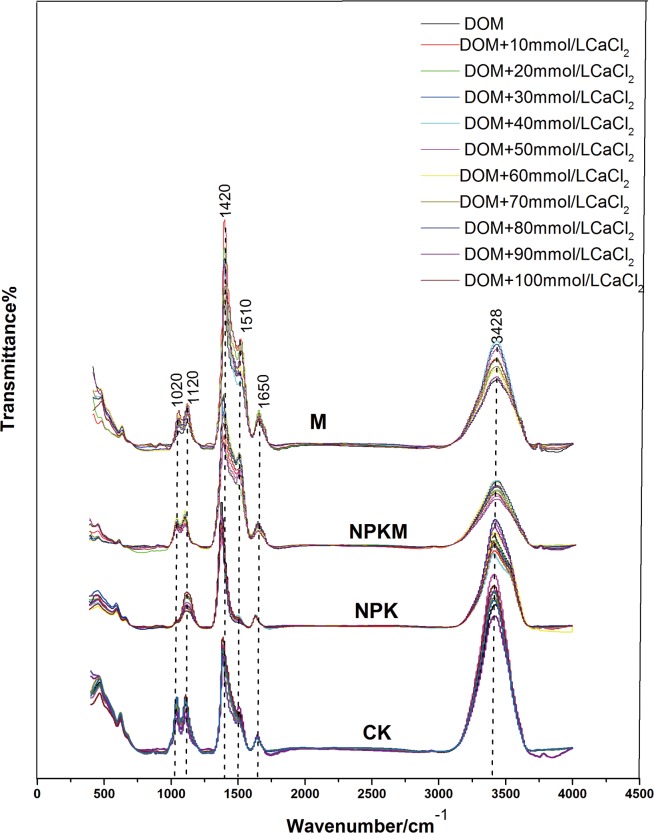
FTIR spectra of the titration of the CK, NPK, NPKM and M treatment depending on the concentrations of CaCl2changes(from 0mmol/L to 100mmol/L).